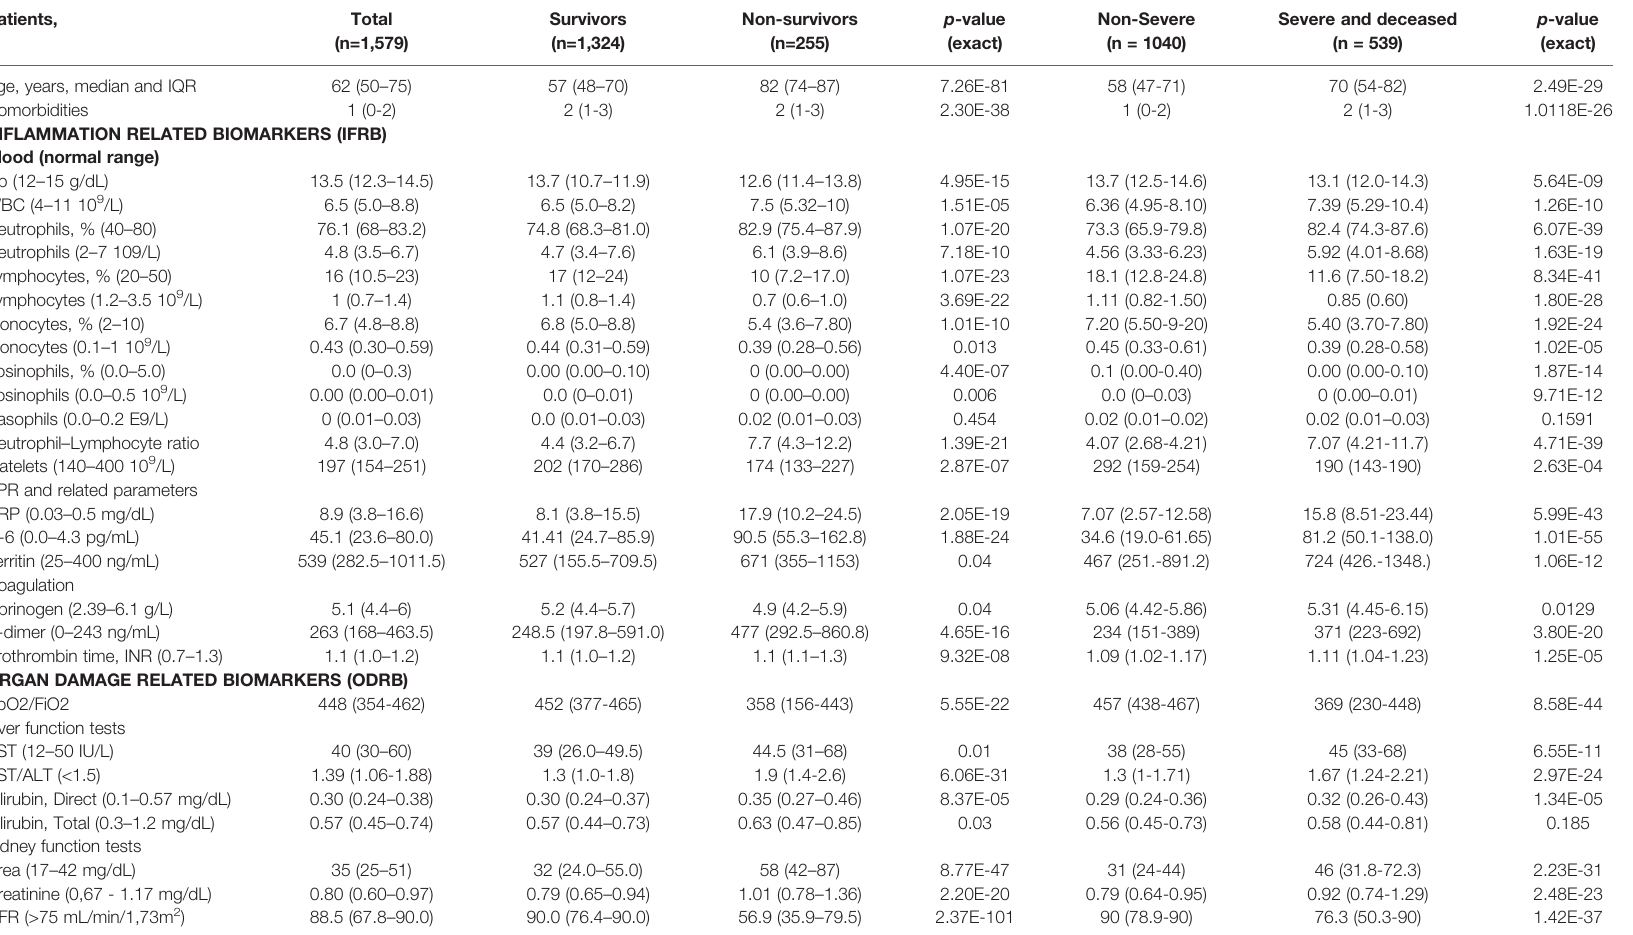
TABLE 2 | Pairwise comparison of biomarkers for decease and severity outcomes, HUVH cohort.